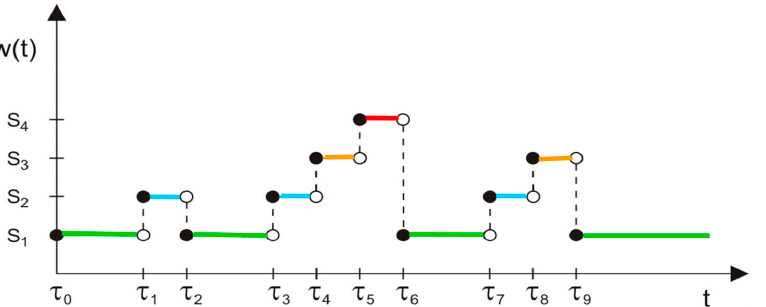
Figure 9. Example of the implementation of the { W(t): t ∈ T } process of a compression ignition